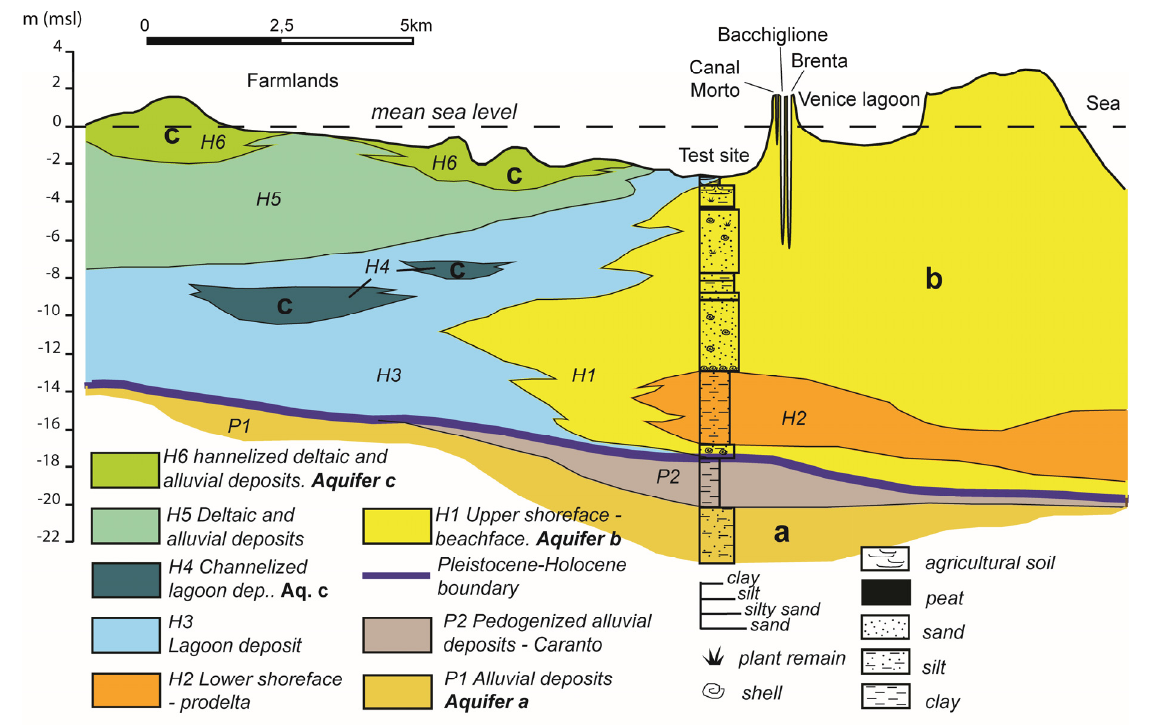
Figure 4. Hydrogeological setting of the upper Pleistocene and Holocene depositional